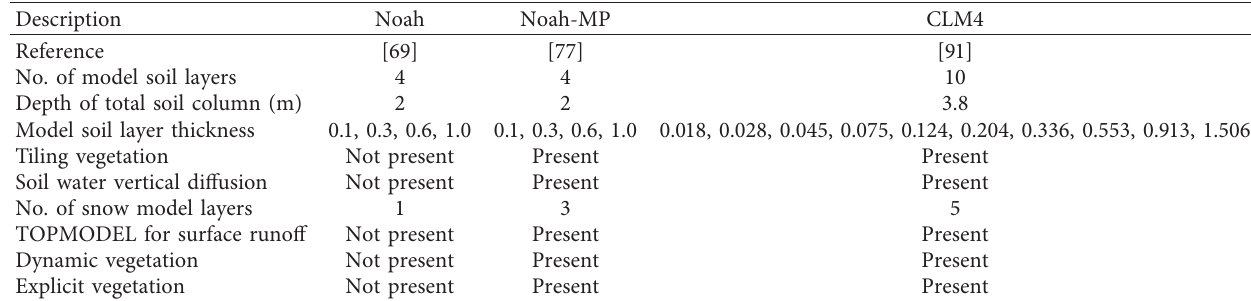
Table 1: Highlights of some major differences between the